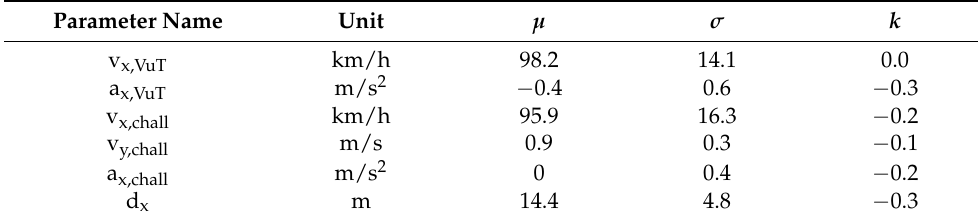
Table 2. Fitted distributions for severe data subset (based on 229 cut-in